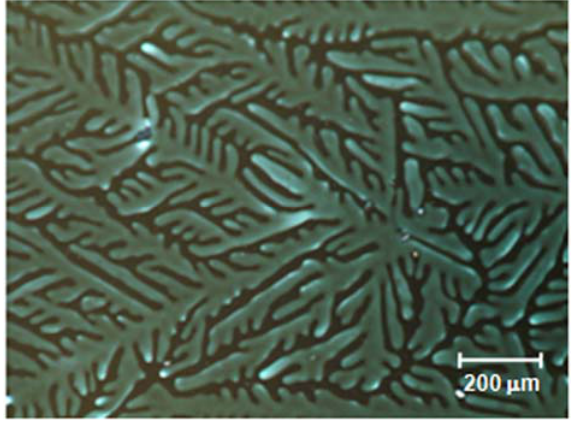
Figure 4. LC10 in a confined cell made using glass plates. The sample was cooled down to 120 ° C from an elevated temperature at a cooling rate of 0.1 °C/min. The pattern reflects a hexagonal symmetry of the columnar structure with the face-on molecular